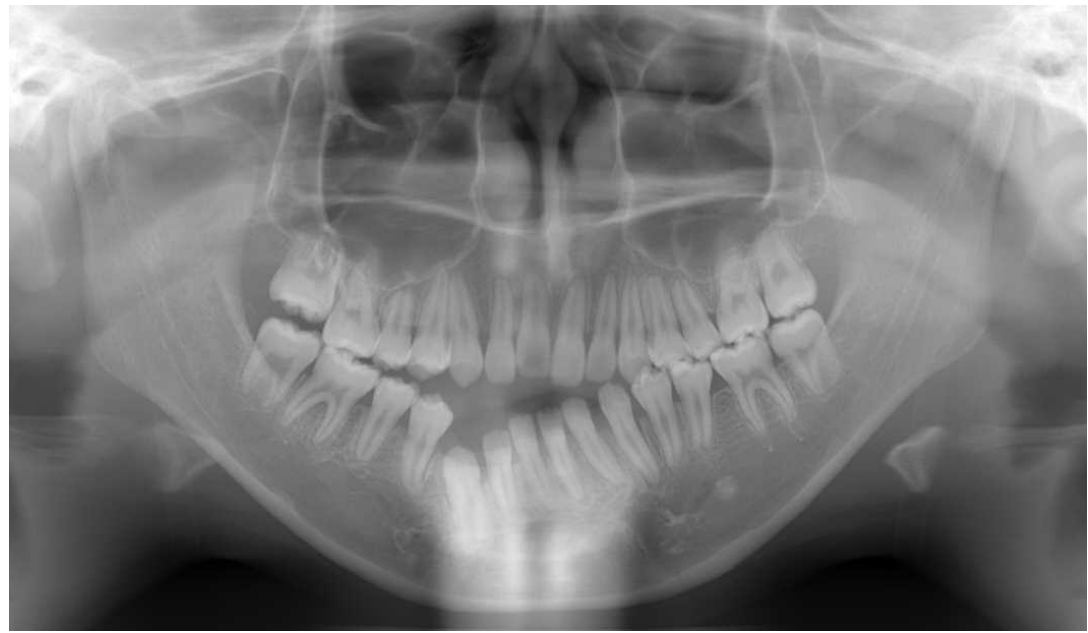
Table 1. Periotest value.